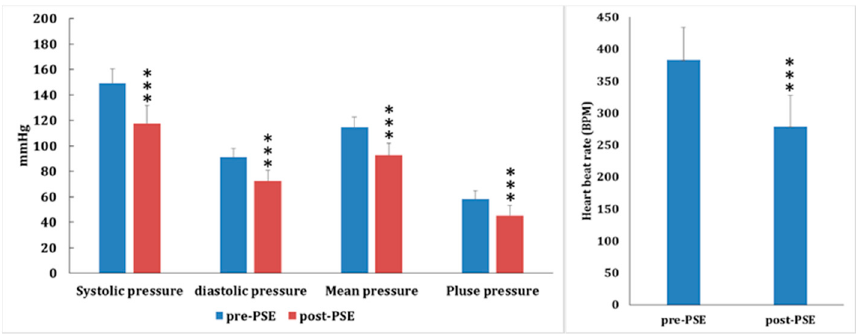
Figure 3. The acute antihypertensive effects of Plantago asiatica seed extracts (PSEs, 360 mg/kg, p.o., 1 h) on P1-HT rats ( n = 15). Systolic pressure decreased about 31.5 mmHg, diastolic pressure decreased about 18.5 mmHg, the mean arterial pressure decreased about 22.3 mmHg, pulse pressure decreased